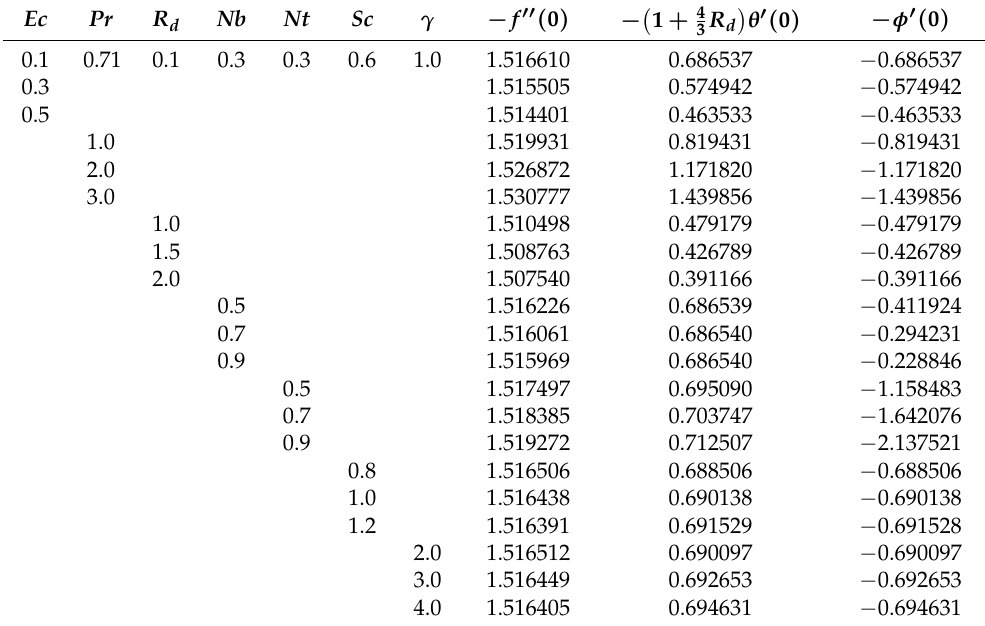
Figure 15. Influence of Nt on the nanofluid concentration. Table 3 displays the values the skin friction coefficient ( − f (cid:48)(cid:48) ( 0 )) , the local Nusselt number ( − θ (cid:48) ( 0 )) and the local Sherwood number ( − φ (cid:48) ( 0 )) for different values of the Eckert number, Prandtl number, thermal radiation parameter, Brownian motion parameter, thermophoresis parameter, Schmidt number and the chemical reaction parameter. It is noted that the − f (cid:48)(cid:48) ( 0 ) is enhanced when the values of Pr and Nt are increased and is suppressed with increased value of Ec , R d , Nb , Sc and γ . The local Nusselt number is an increasing function of Pr , Nt , Sc , and γ whilst it decreases when the values of Ec , R d and Nb are increased. It is observed that there is an upsurge in the local Sherwood number with increasing Pr , Nt , Sc and γ whilst an opposite trend is realised when Ec , R d and Nb are increased. Table 3. Computation of the values of skin friction coefficient ( − f (cid:48)(cid:48) ( 0 )) , the local Nusselt number ( − θ (cid:48) ( 0 )) and the local Sherwood number − φ (cid:48) ( 0 ) for different values of Ec , Pr , R d , Nb , Nt , Sc , γ when (cid:101) = 0.1, β = 0.1, M = 0.1, A =